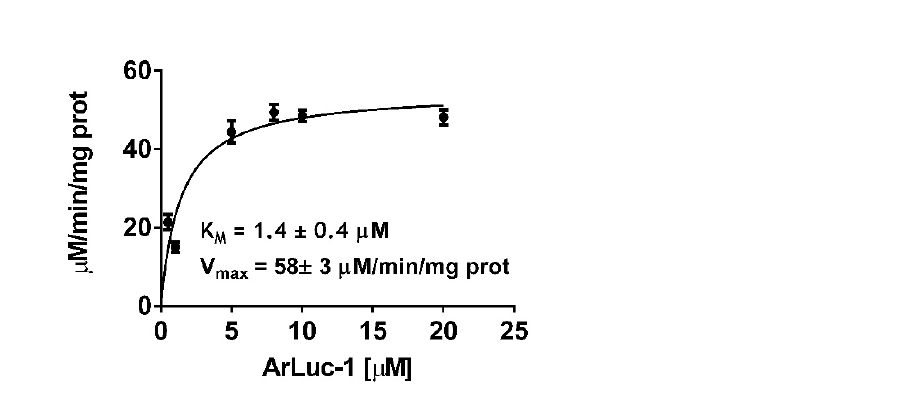
Figure 5. Kinetic study of MAGL activity with ArLuc- 1 . Data are reported as mean ± SD. The curve model is that of the Michaelis–Menten.